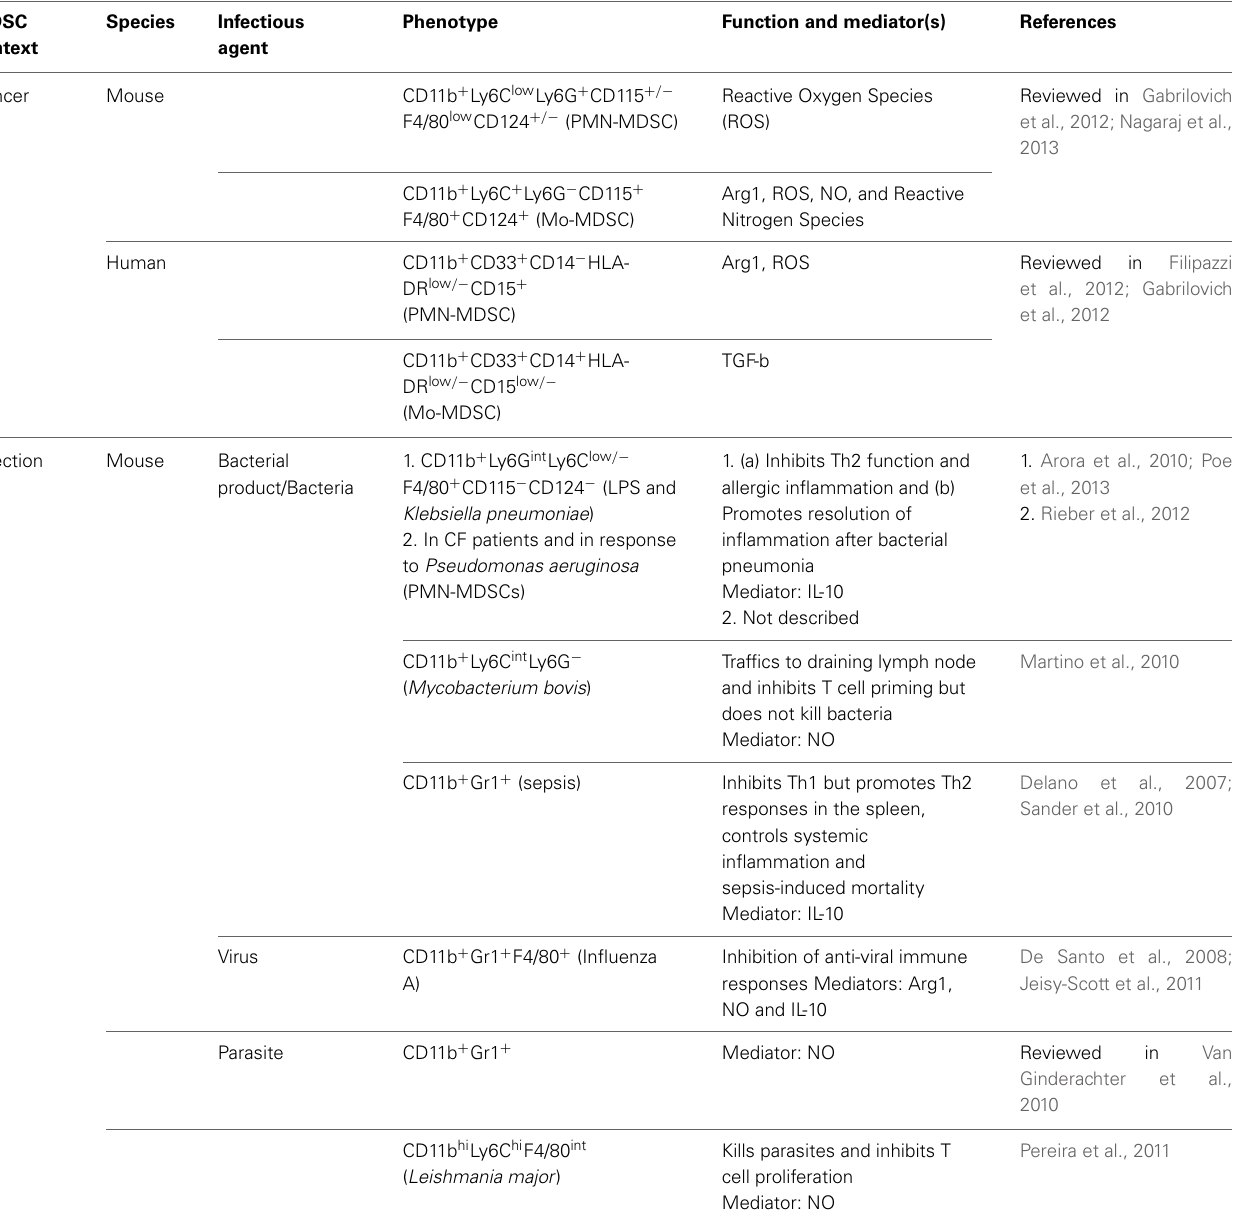
Table 1 | MDSCs in cancer and